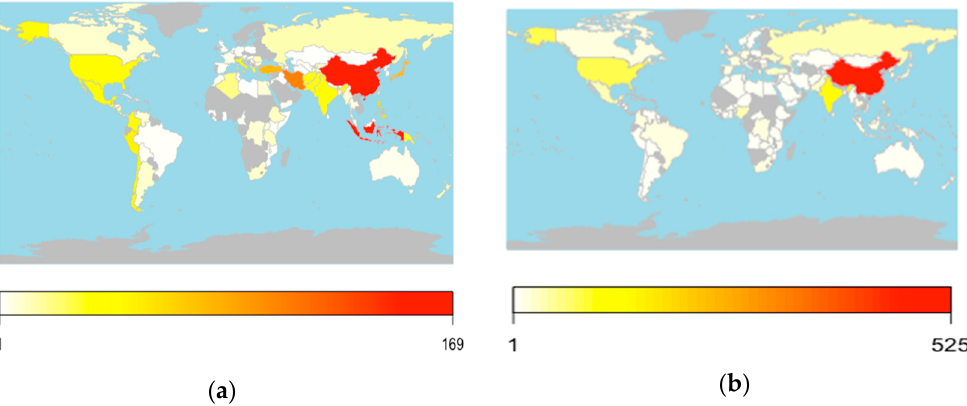
Figure 1. Maps of occurrence. ( a ) Geophysical hazards and ( b ) industrial hazards. Note: The scale of maps represents cumulative observations of event occurrences in each country over the years since 1900.